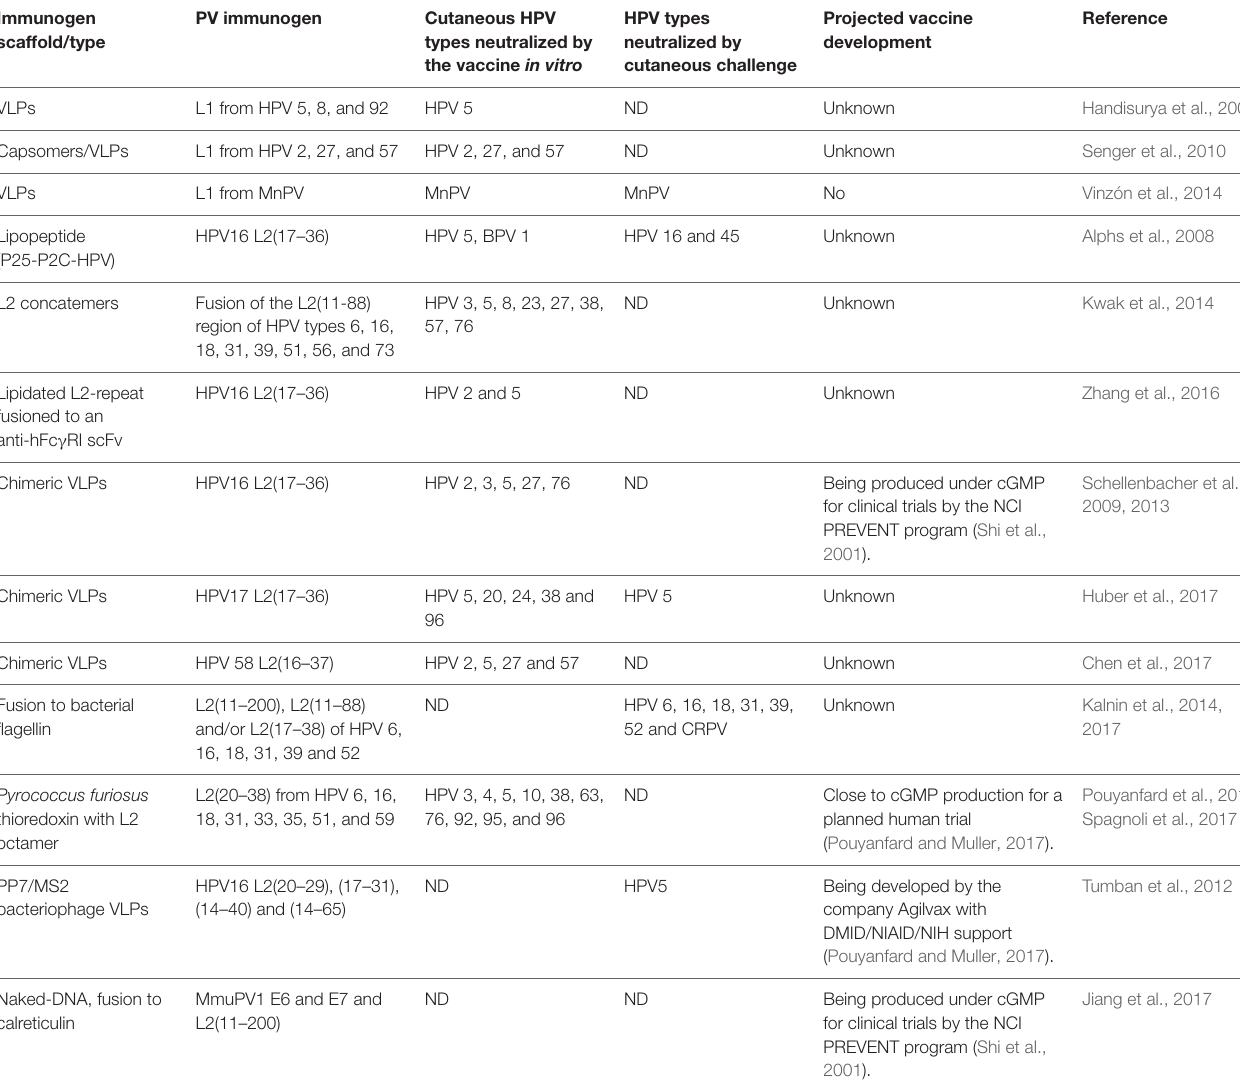
TABLE 1 | Preclinical studies showing reactivity of HPV vaccines to cutaneous